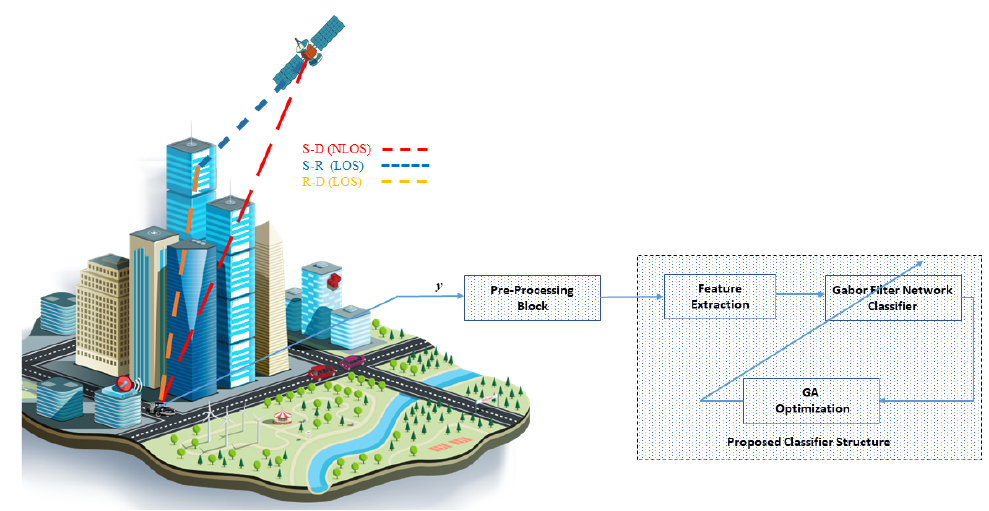
Figure 1. System